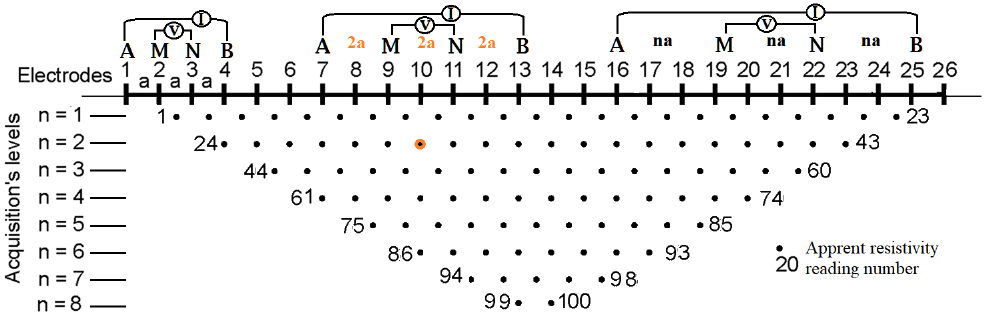
Figure 3. Schematic of electrode arrangement and the sequence of measurements used to build apparent resistivity pseudo-sections.